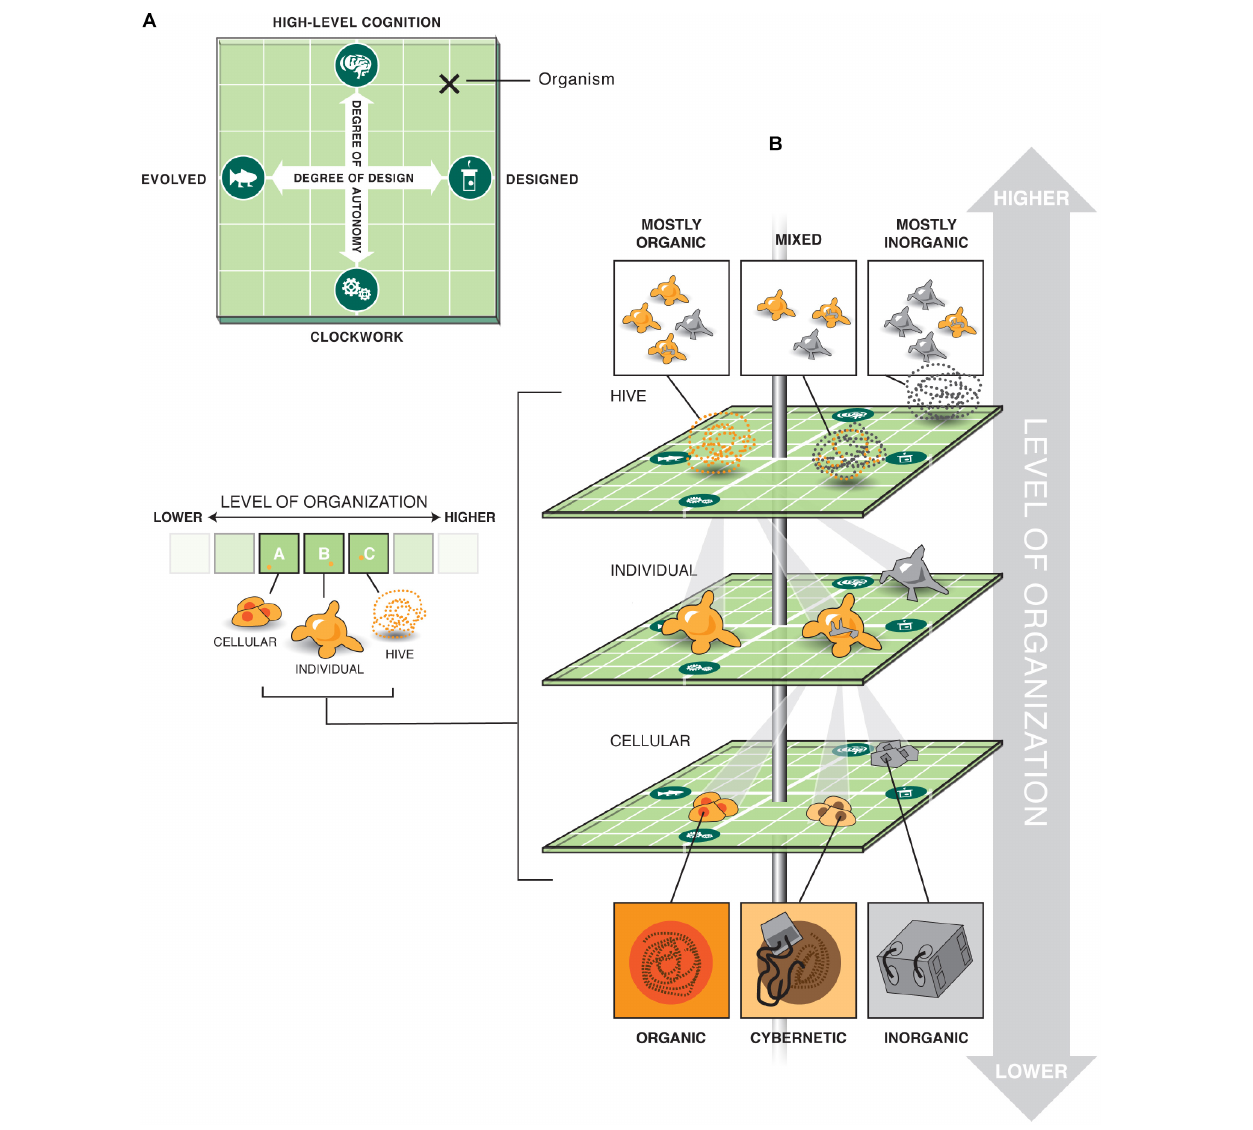
FIGURE 1 | Multi-scale option space for possible living machines. (A) Two orthogonal axes define important aspects of any complex system: the degree of design vs. evolution that created it, and the degree of amount of autonomy it is able to implement. We suggest that both of these principal components are not binary categories (such as evolved vs. designed, mechanical vs. autonomous/cognitive) but rather continuous. Together, they form a 2-dimensional option space within which a great variety of possible agents can be placed. (B) Importantly, such an option space exists at each level of organization (for example, the familiar biological nested scales of cells, individual organisms, and hives/swarms), and each level comprising a complex agent could occupy a different position in the option space – the levels can be independent with respect to how much evolution, design, and cognition they involve. For example, a given system could be in one corner of the option space at the lowest level (e.g., contain cells that include highly predictable synthetic circuits), but be evolved and intelligent at the level of the individual, and at the same time be part of a swarm containing a mix of designed and evolved agents made up of different elements elsewhere on the option space in (A)